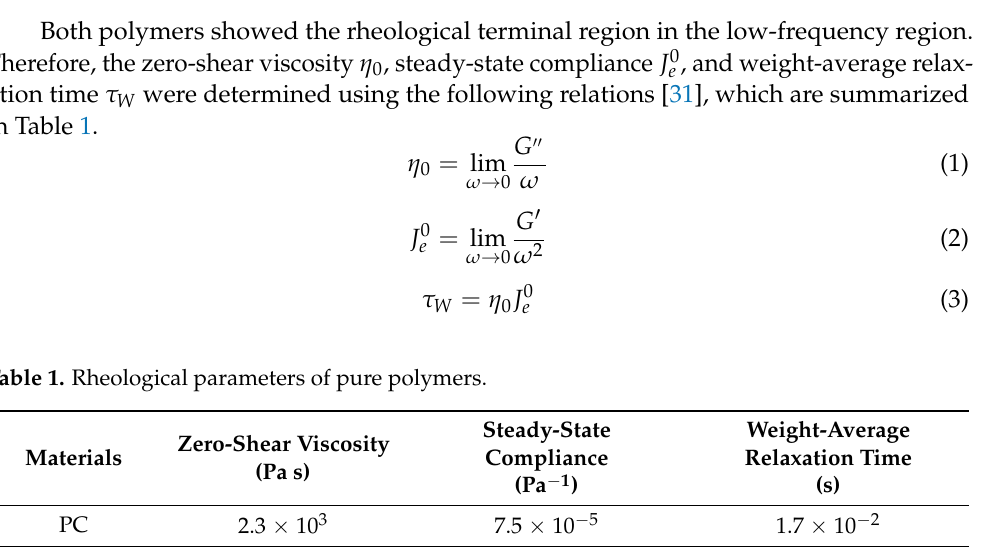
Table 1. Rheological parameters of pure polymers.